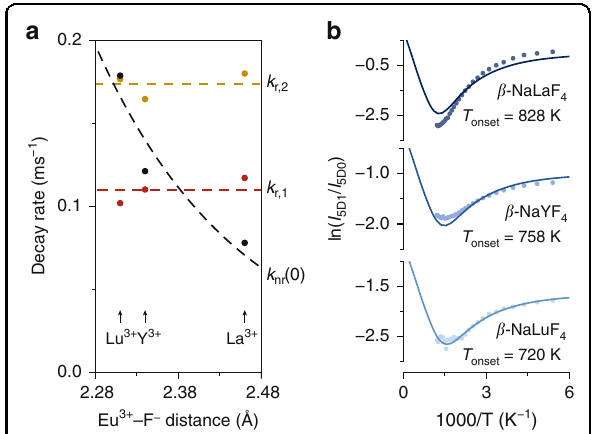
Fig. 3 Tuning the intrinsic nonradiative rate via the lanthanide – ligand distance. a Radiative rates of 5 D 0 ( k r ; 1 ) and 5 D 1 ( k r ; 2 ) and the intrinsic nonradiative rate between these levels k nr ð 0 Þ for Eu 3 + in β -NaLuF 4 , β -NaYF 4 , and β -NaLaF 4 . Similar to the procedure described in Sec. S1, luminescence measurements at 7 K were used to determine these rates. The dashed lines serve as guide to the eye. b Intensity ratios between the 5 D 1 and 5 D 0 emissions for various temperatures determined from luminescence spectra upon excitation at 395 nm in 5 L 6 . The solid lines are the result of a global fi t of the experimental ratios (dots) to the model of Eq. 4 (lines), where one value of pre-factor C and one value of the vibrational energy (cid:1) h ω and three different values of feeding factor α were used as fi tting parameters. The onset temperatures were calculated using Eq.